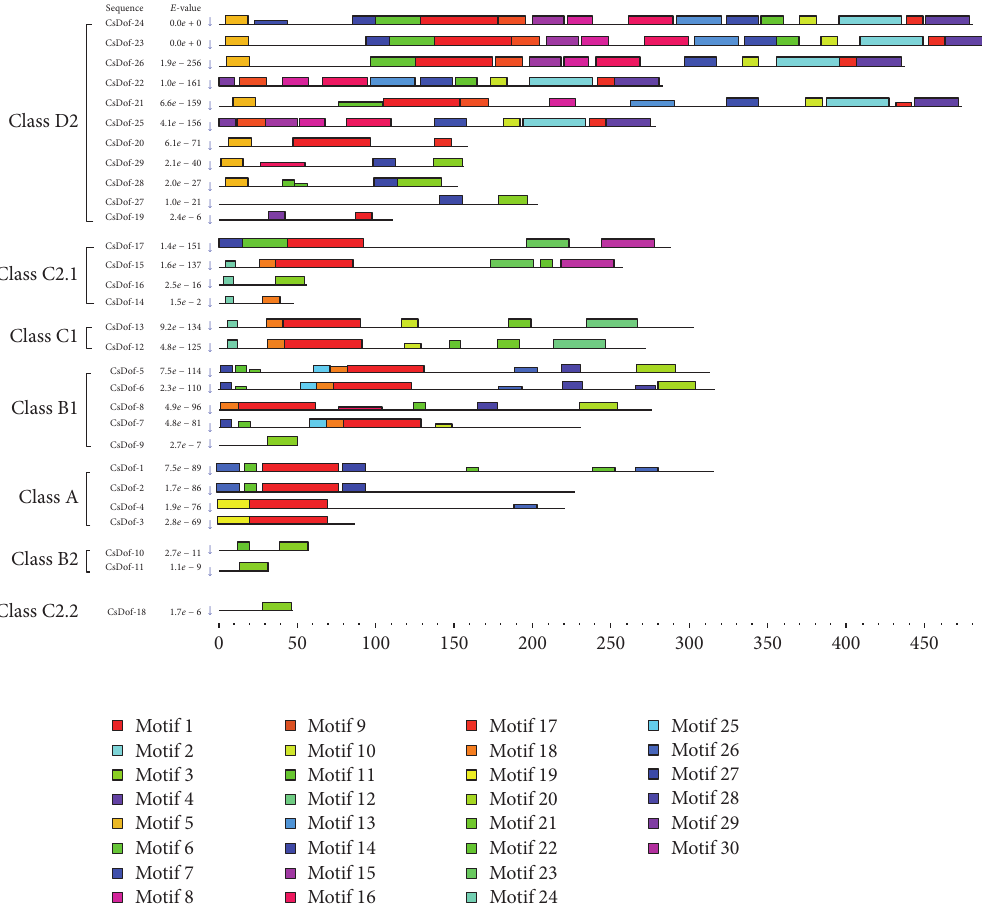
Figure 4: Common motifs of CsDof family proteins in C. sinensis